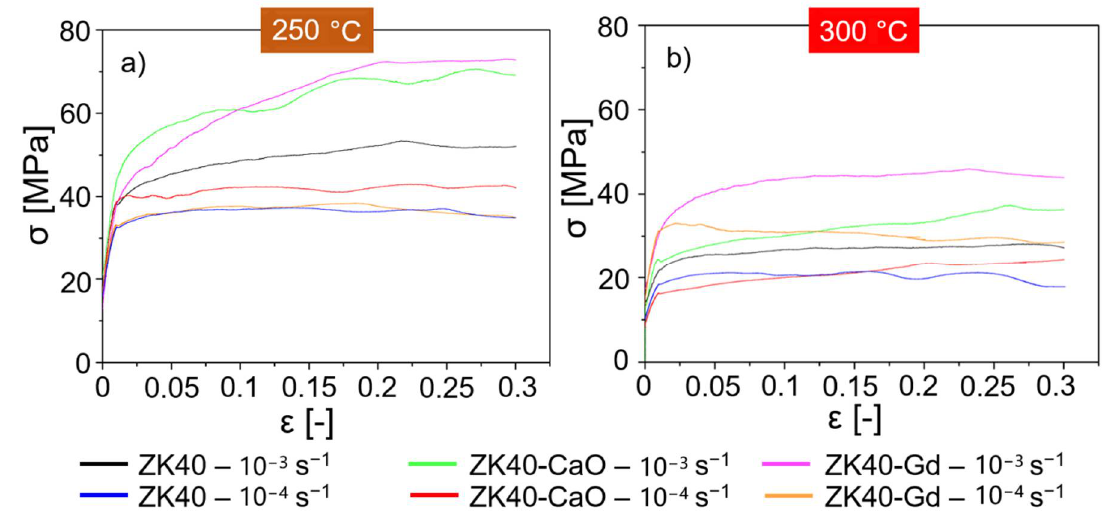
Figure 2. Flow stress for the alloys tested at ( a ) 250 °C and ( b ) 300 °C.